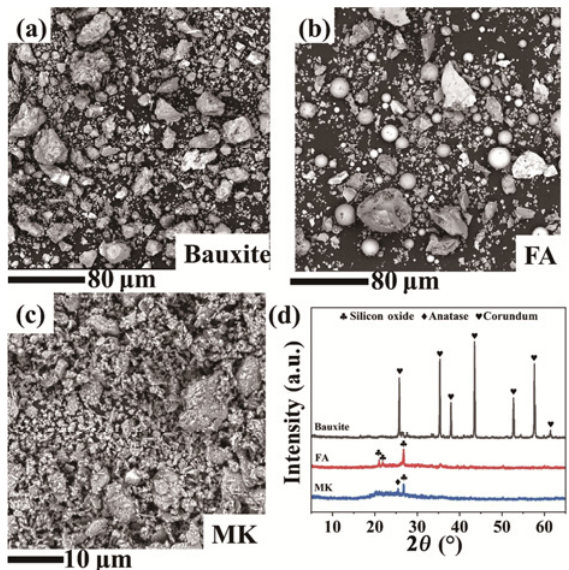
Fig. 2 (a–c) SEM images and (d) XRD patterns of individual raw